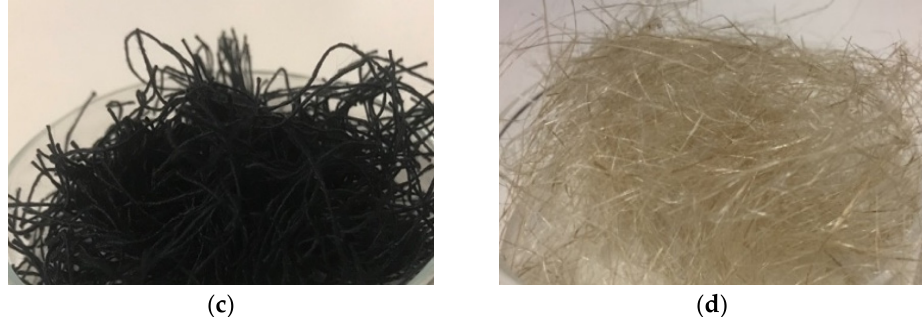
Figure 1. Fibre’s waste used: ( a ) wool fibres, ( b ) coir fibres, ( c ) textile-acrylic fibres and ( d ) flax fibres.